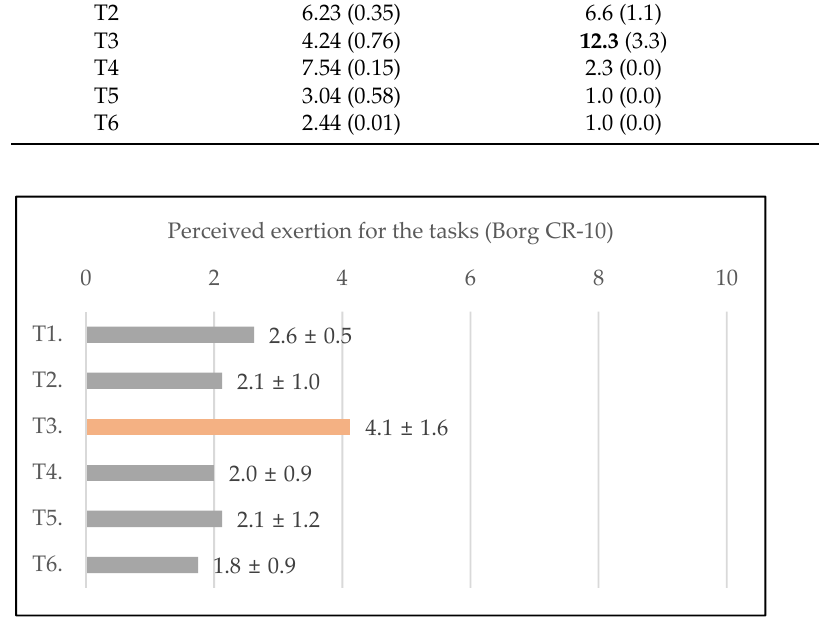
Figure 6. Perceived exertion (mean values ± SD) across the tasks ( n = 8 workers).